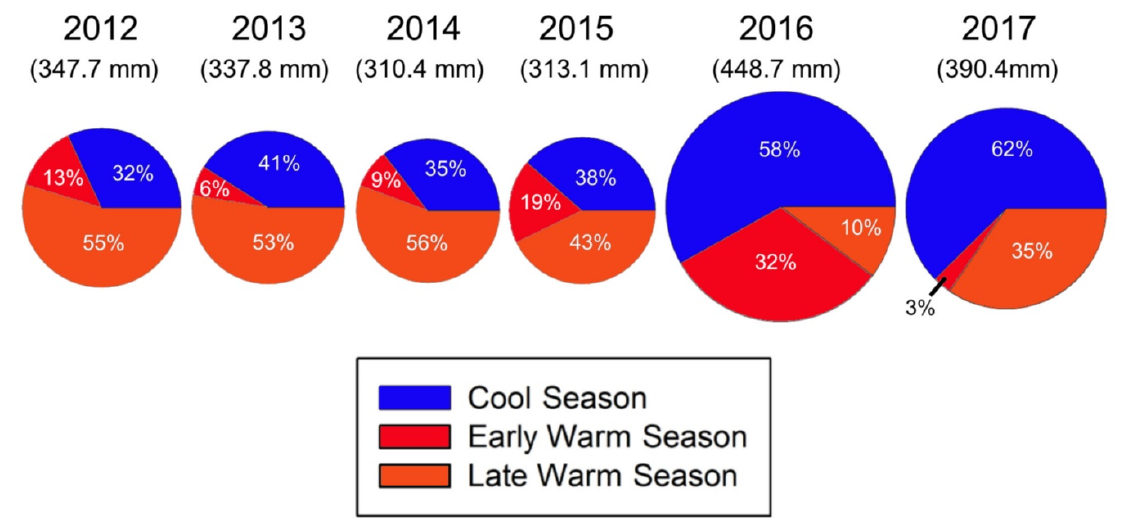
Figure 3. Precipitation percentages at our study site for cool (1 October–31 March), early warm (1 April to the day prior to 9.4 ◦ C dewpoint threshold), and late warm (day of 9.4 ◦ C dewpoint threshold